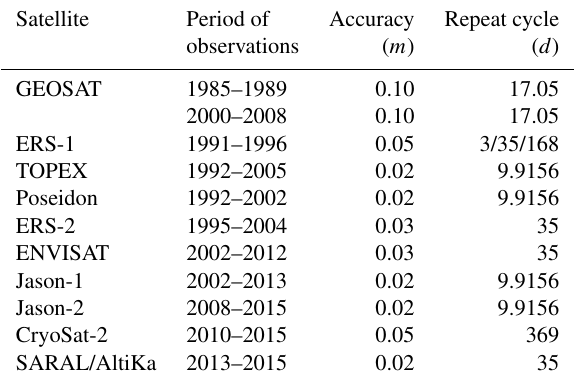
Table 1. Description of satellite missions used in the paper. As the number of observations made by the TOPEX/Poseidon mis- sion was small, it was not possible to adequately validate these data (Kudryavtseva and Soomere 2016); the relevant data set is not used in the analysis presented in this